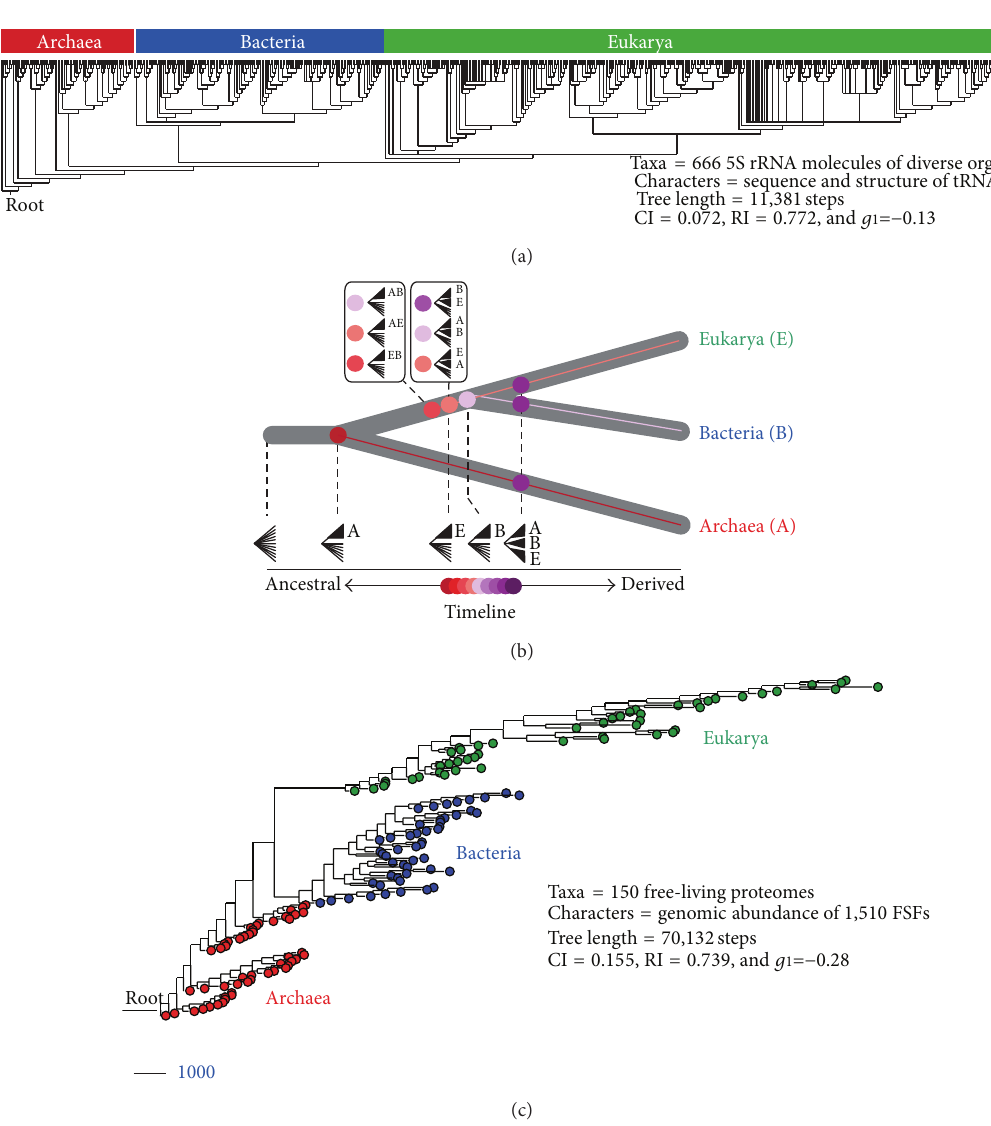
selected conformations and decreasing their relative